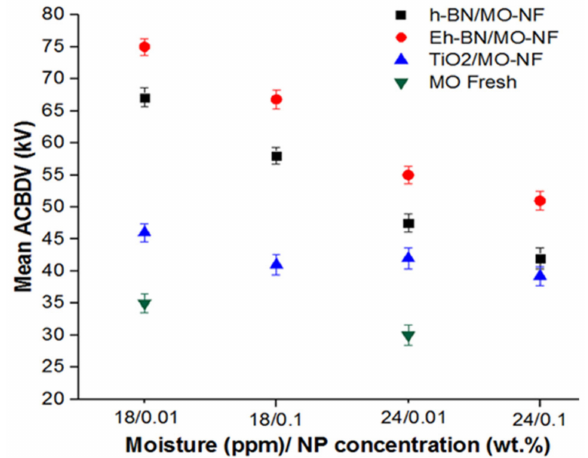
Figure 3. Mean ACBDV of MO and NFs at 18 and 24 ppm moisture